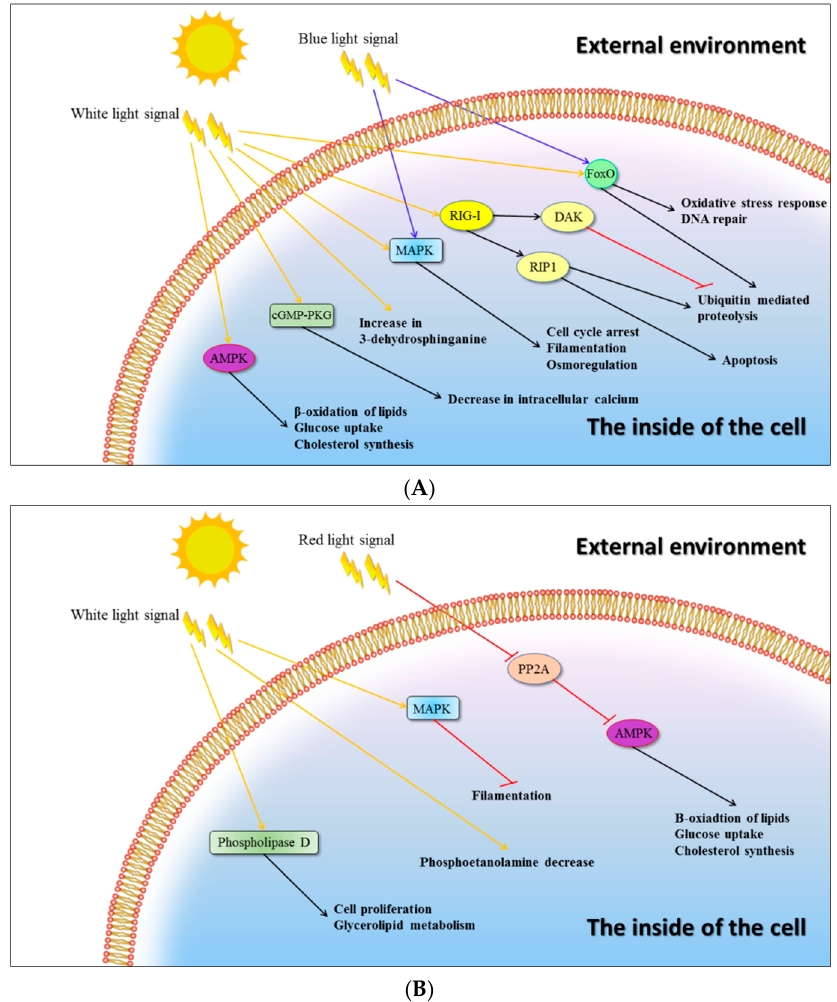
Figure 3. Putative light-regulated signalling pathways in C. unicolor FCL139. The effect of white (W), blue (B), and red (R) light on the up-regulation ( A ) and down-regulation ( B ) of genes coding for putative signal-transducing molecules and their engagement in metabolic pathways has been indicated. Arrow-headed lines and bar-headed lines indicate activation and inhibition, respectively. The colour of an arrow ‐ headed line corresponds to the specific wavelength of light.